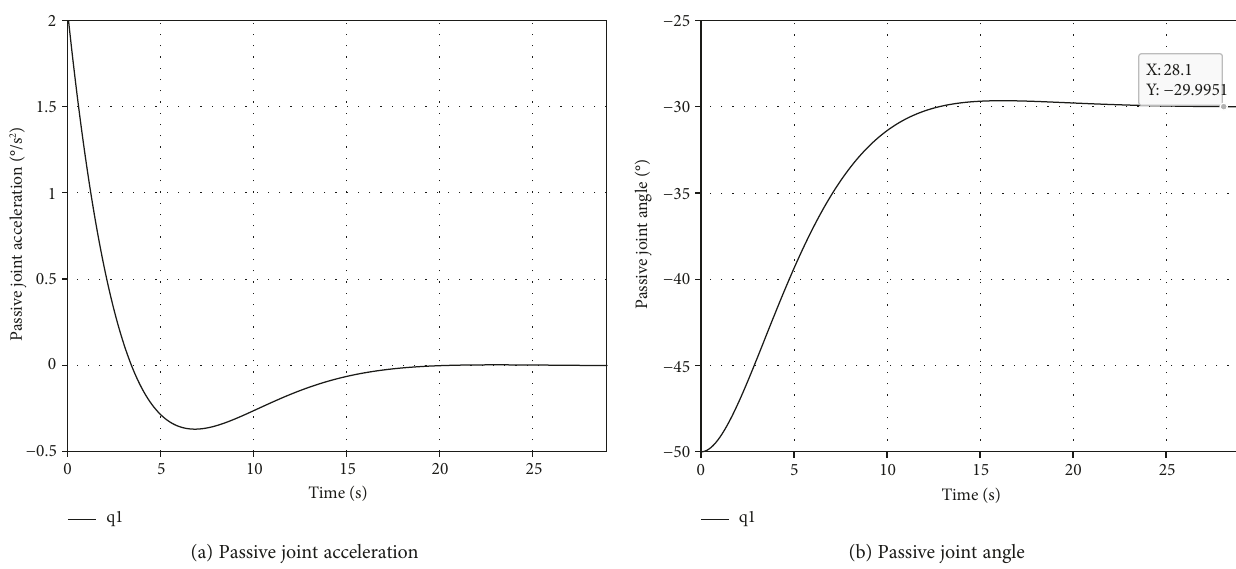
and η g with m . c PA PA